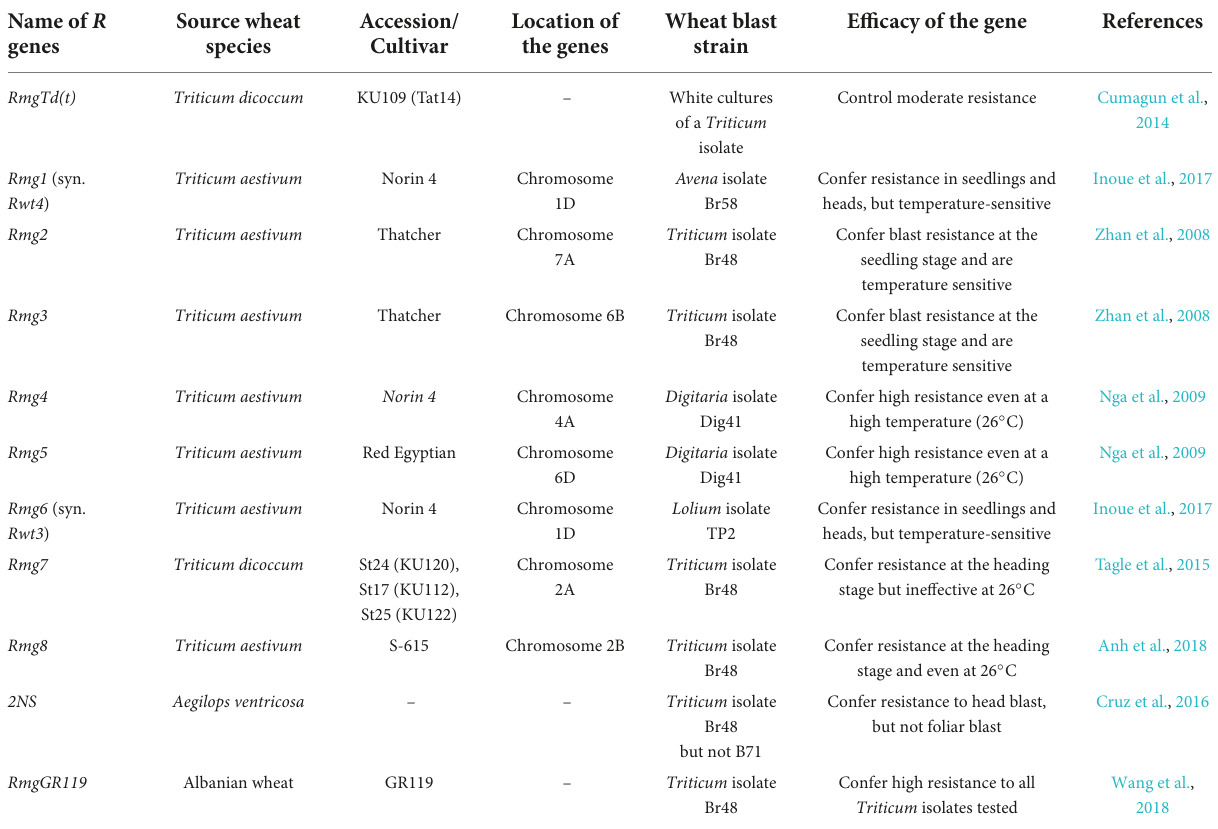
TABLE 2 List of R genes identified against various strains of wheat blast